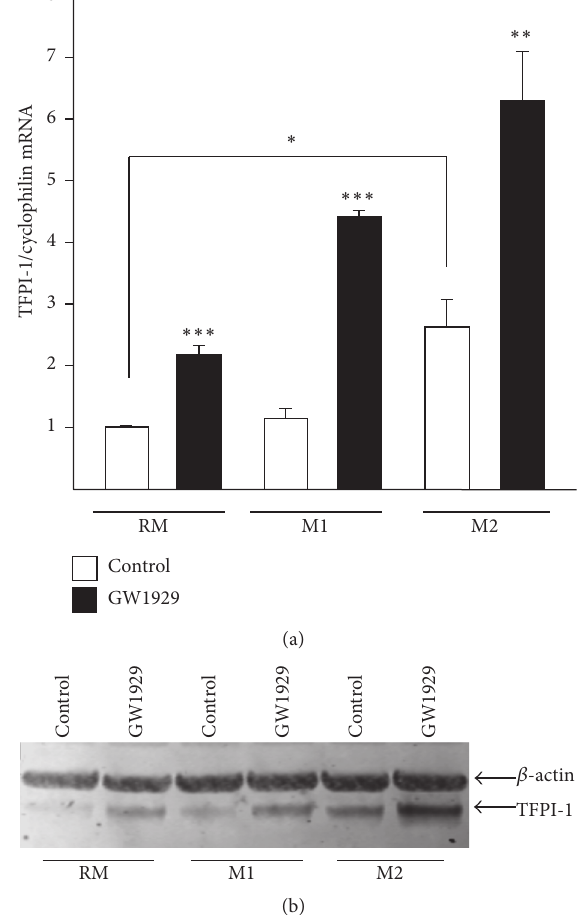
Figure 3: PPAR 𝛾 activation induces the expression of TFPI-1 in human primary macrophages irrespectively of their phenotype. Primary human monocytes were differentiated into resting unpo- larized (RM) or M2 macrophages in the absence or in the presence of IL-4 (15ng/mL) for 7 days, respectively, and then treated for 24 h with GW1929 (600nM). M1 macrophages were obtained by activation of RM macrophages with LPS (100ng/mL) for 4h in the absence or in the presence of GW1929 treatment (24h, 600nM). (a) TFPI-1 mRNA levels were measured by Q-PCR, normalized to cyclophilin mRNA, and expressed relative to the levels in untreated cells set as 1. Results are representative of those obtained from 3 independent macrophage preparations. Each bar is the mean value ± SD of triplicate determinations. Statistically significant differences between treatment and control groups are indicated ( ∗ 𝑝 < 0.05 ; ∗∗ 𝑝 < 0.01 ; ∗∗∗ 𝑝 < 0.001 ). (b) TFPI-1 protein expression was analyzed by western blot. 𝛽 -actin was used as loading